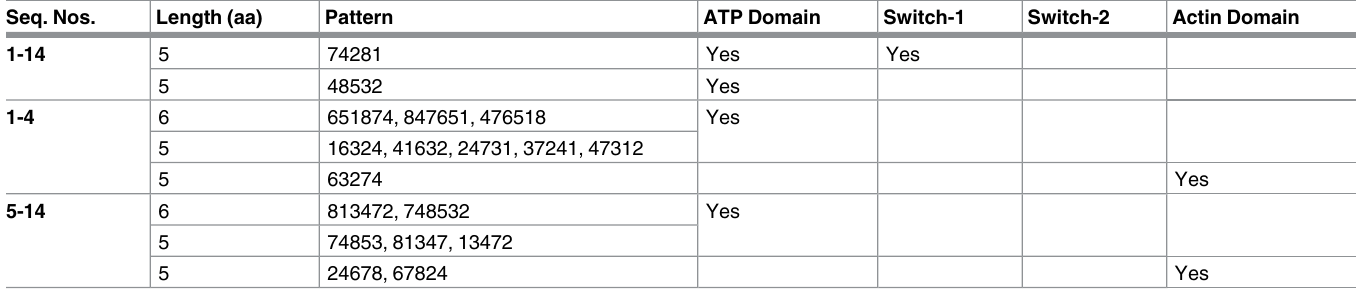
Table 15. Specific patterns of the amino acids and their location into different sub-domains of the myosin II head domain. Seq. Nos.